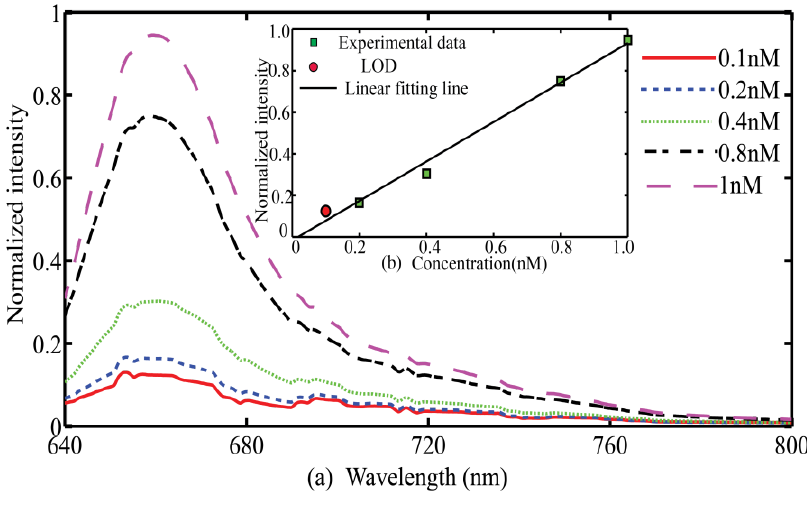
Figure 5. ( a ) Fluorescence spectra for each concentration; ( b ) Plot of normalized fluorescence intensities against solution